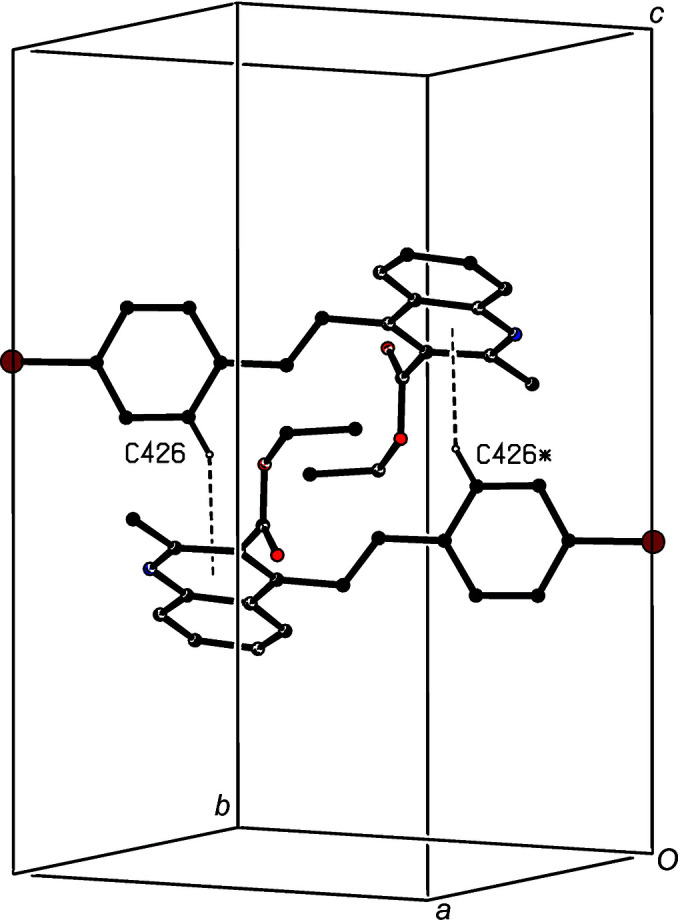
Part of the crystal structure of com­pound (V), showing the formation of a centrosymmetric dimer. Hydrogen bonds are drawn as dashed lines and, for the sake of clarity, H atoms which are not involved in the motif shown have been omitted. The atom marked with an asterisk (*) is at the symmetry position (−x + 1, −y + 1, −z + 1).